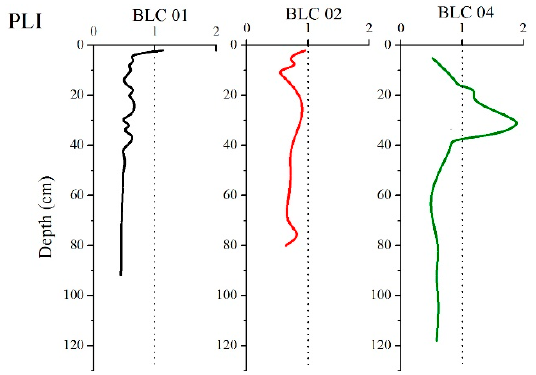
Figure 7. Vertical profiles of PLI for all core samples of Batticaloa lagoon.